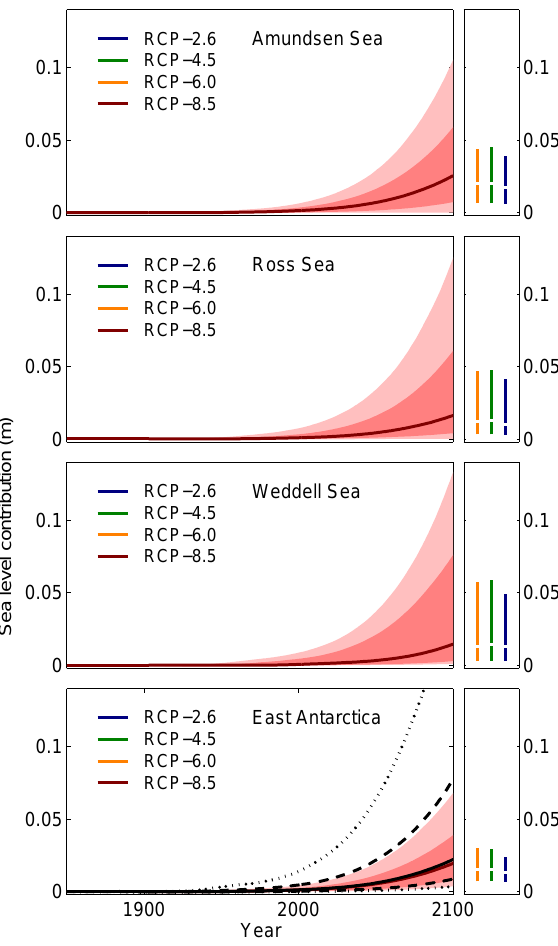
Figure 8. Uncertainty range of contributions to global sea level from basal-melt induced ice discharge from Antarctica for the dif- ferent basins. Results shown here include the three ice-sheet models with explicit representation of ice-shelf dynamics and the global cli- mate forcing applied with a time delay as given in Tables 2–5. The full red curve is the median enclosed by the dark shaded 66% range and the light shaded 90% range of the distribution for the RCP-8.5 scenario. Coloured bars at the right show the other scenarios’ 66% range intersected by the median. The full distribution is given in Fig. 9. The strongest difference between models with and without explicit representation of ice shelves occurs in East Antarctica as exemplified in the lower panel. The dashed black line envelopes the 66% range of all models, the full black line is the median and the dotted line the 90%